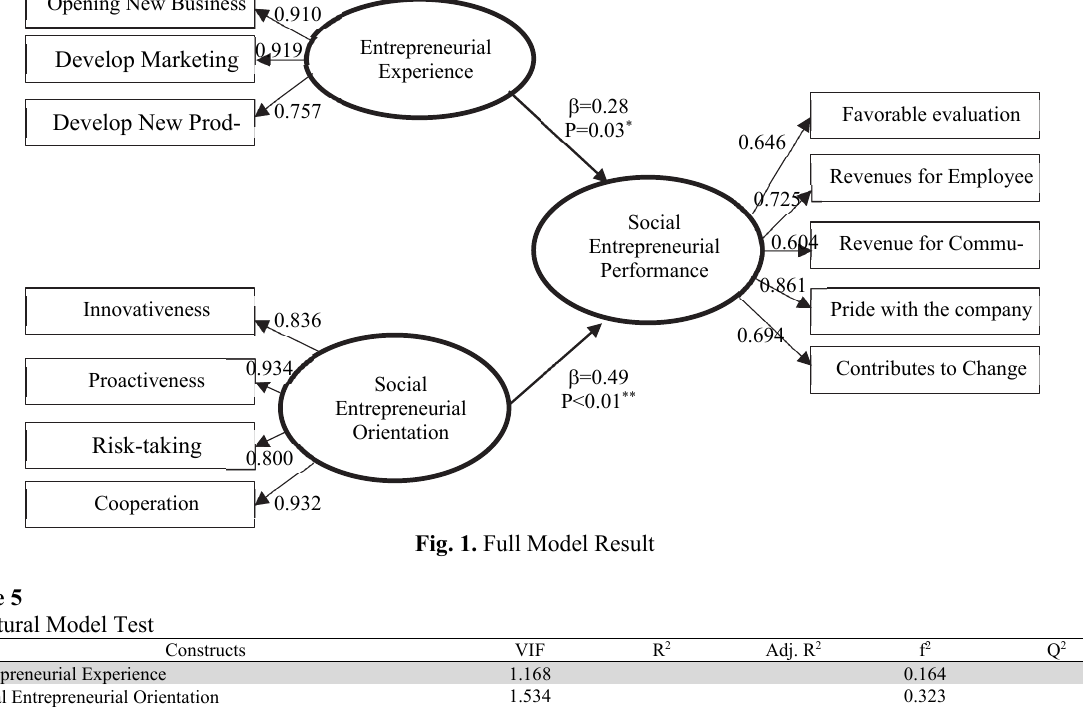
Structural Model Test